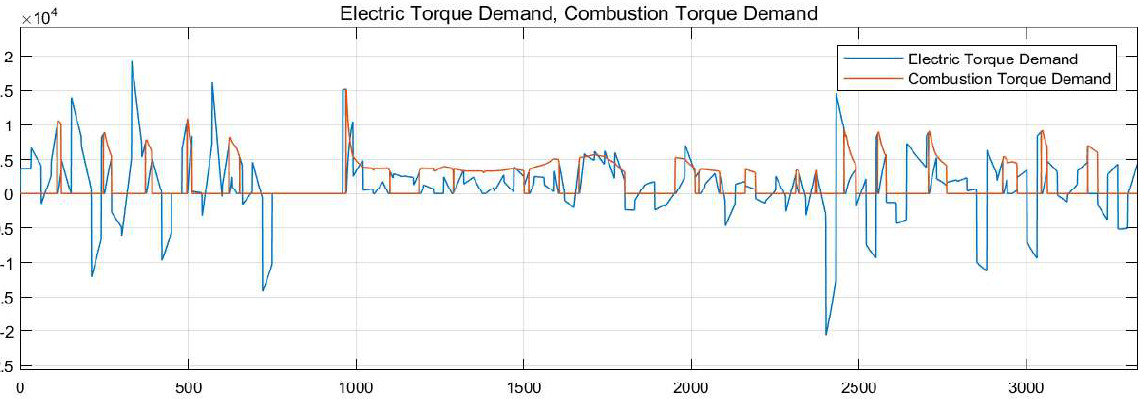
Figure 12. Power split on TTRP hybrid: torque demand from electric motor and torque demand from diesel engine.